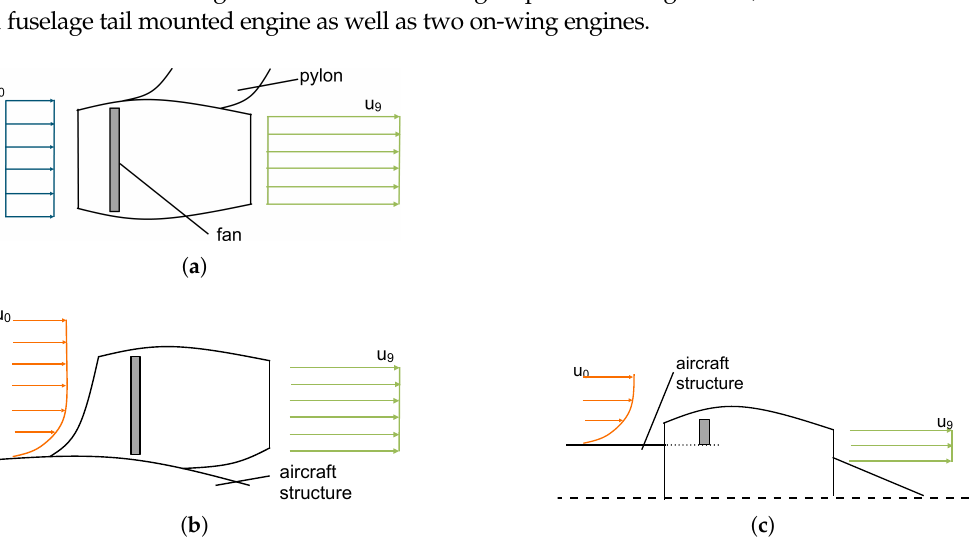
Figure 2. ( a ) Podded vs. ( b ) asymmetric BLI vs. ( c ) full annular BLI engine configuration (Partly based on [12] Figure 5, under CC BY 4.0) (accessed on 25 April